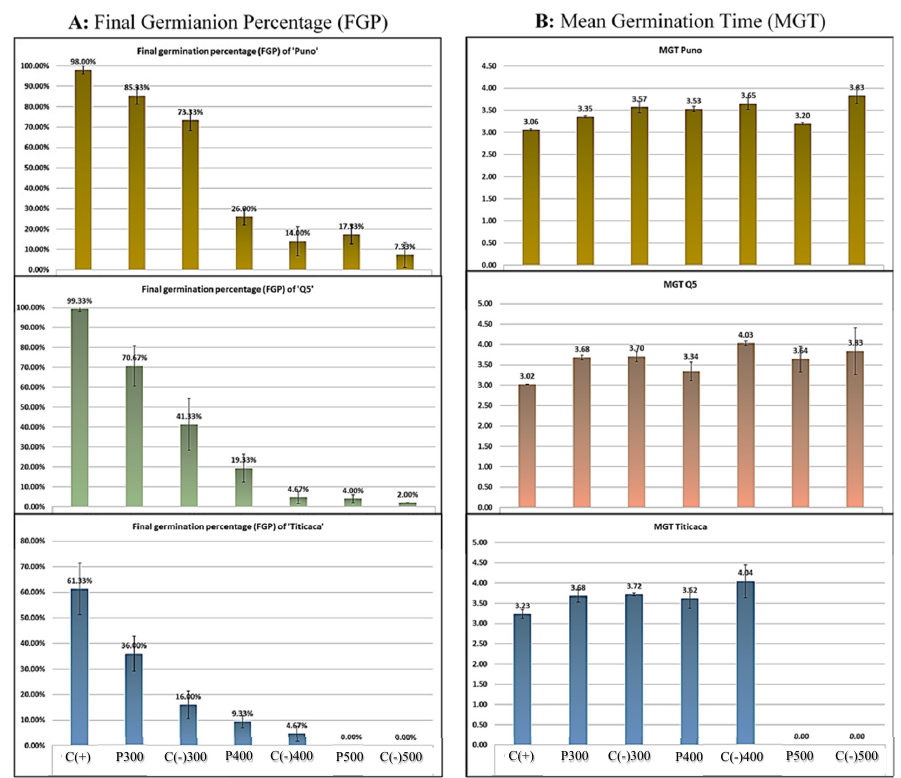
Figure 1. Effect of zinc sulfate priming on the final germination percentage (FGP) ( A ) and the mean germination time (MGT) ( B ) in three quinoa varieties, “Puno, Q5 and Titicaca”, positive control “C(+)” refers to unprimed and non-stressed seeds; negative control “C(-)300; C(-)400; C(-)500” refers to unprimed seeds germinated in 300, 400 and 500 Mm NaCl, respectively; “P300; P400; P500” refers to the primed seeds germinated in 300, 400 and 500 Mm NaCl, respectively. Results were means ± SD of the three replicates.